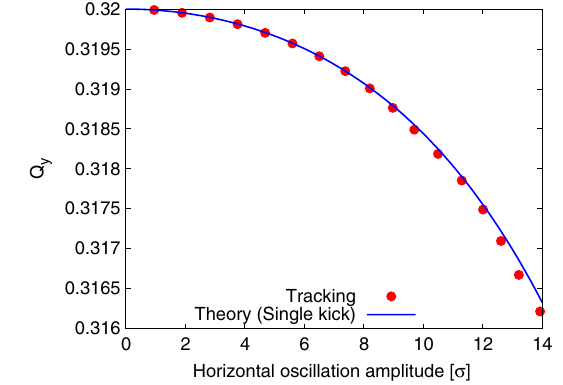
FIG. 4. Cross term of amplitude detuning for the combined effect of nonlinear field components up to B 10 . The red dots are the result of the tracking; the blue line is the model prediction for free oscillation. Tracking data are consistent with the free oscillation term.